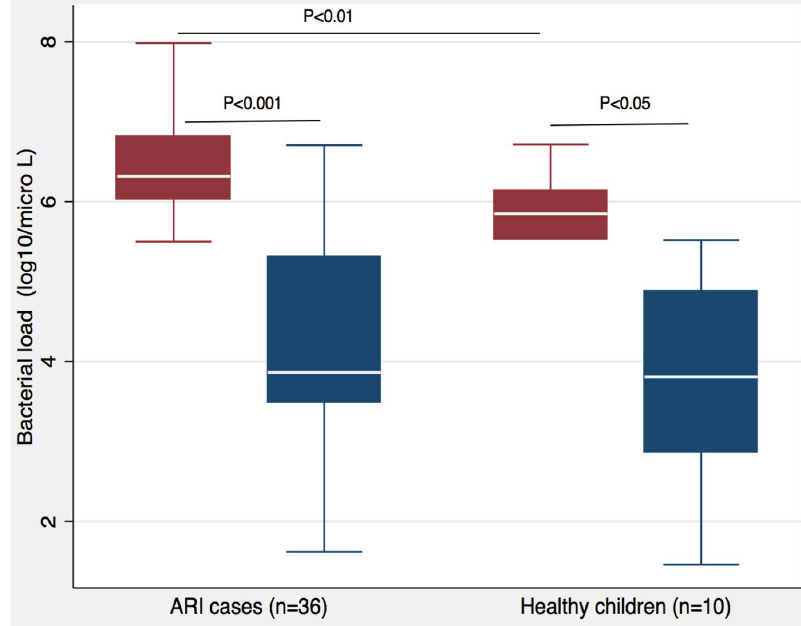
Figure 6. Dominance of one serotype/serogroup over the other in co-colonization of multiple serotypes/serogroups. Among two serotypes/serogroups present in a co-colonization, one serotype/serogroup (red) was found to be dominant by having 100 folds (2 log10) higher bacterial load than the other subdominant (blue) serotype/serogroup both in ARI cases and healthy children.